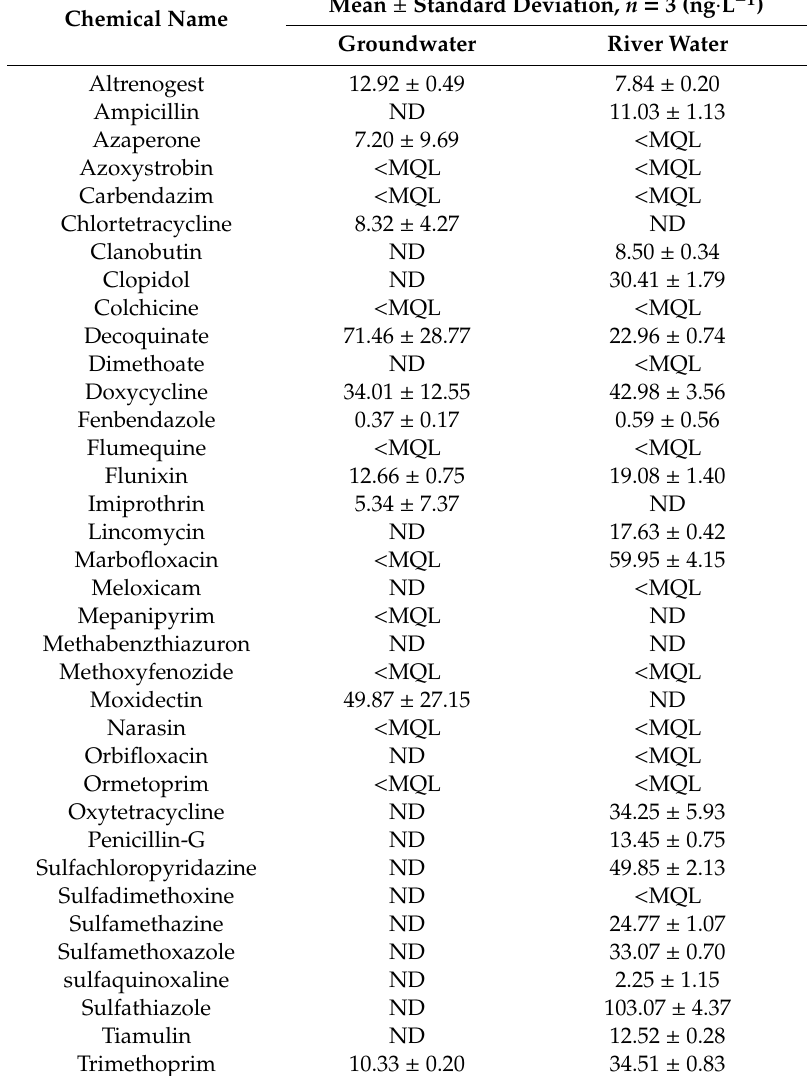
Table 7. Analysis results using the developed method with on-line SPE for target agrochemicals in environmental water samples (groundwater and surface water). ND—not